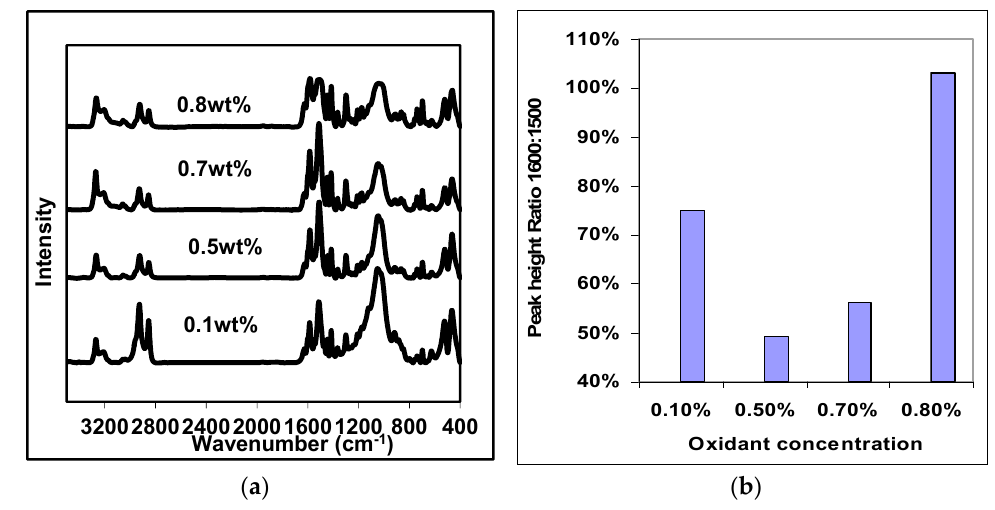
Figure 5. FTIR spectra of PACN synthesized at different oxidant concentration ( a ), and ratio of 1600 to 1500 cm − 1 peak height ( b ).